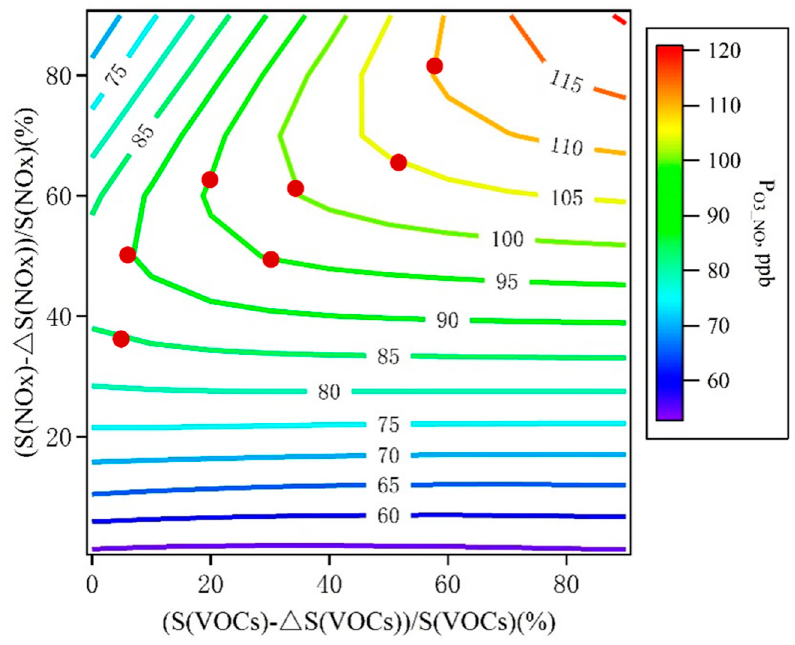
Figure 3. EKMA plot generated from the study period.